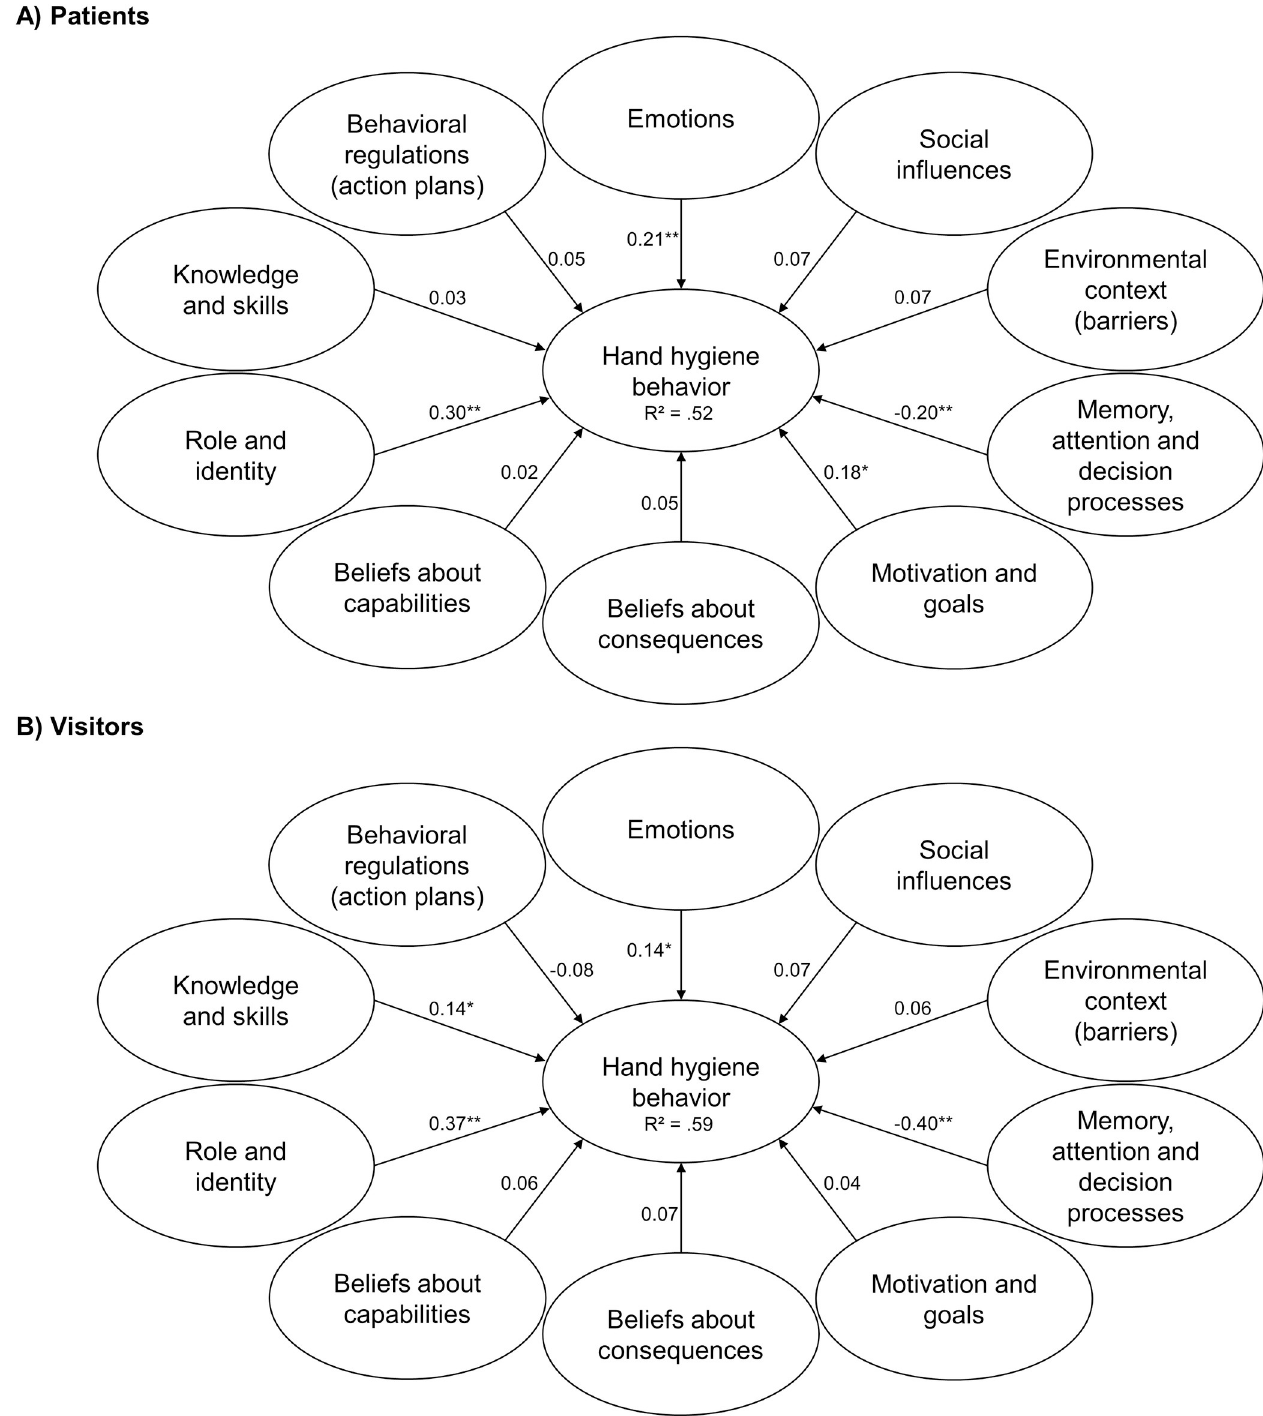
Fig 4. TDF path models with standardized parameter estimates to predict hand hygiene behavior. Note: � p < .05, �� p < .001, n = 273, n = 245, n = patients) (total visitors) (used visitors)